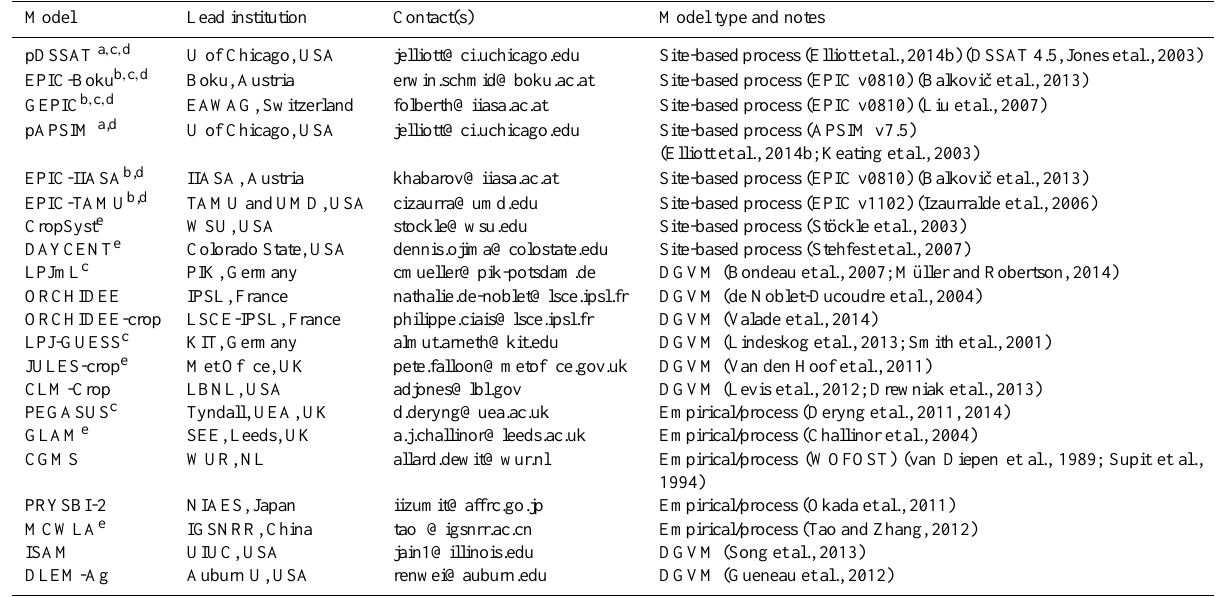
Table 1. Models and groups engaged thus far for GGCMI.